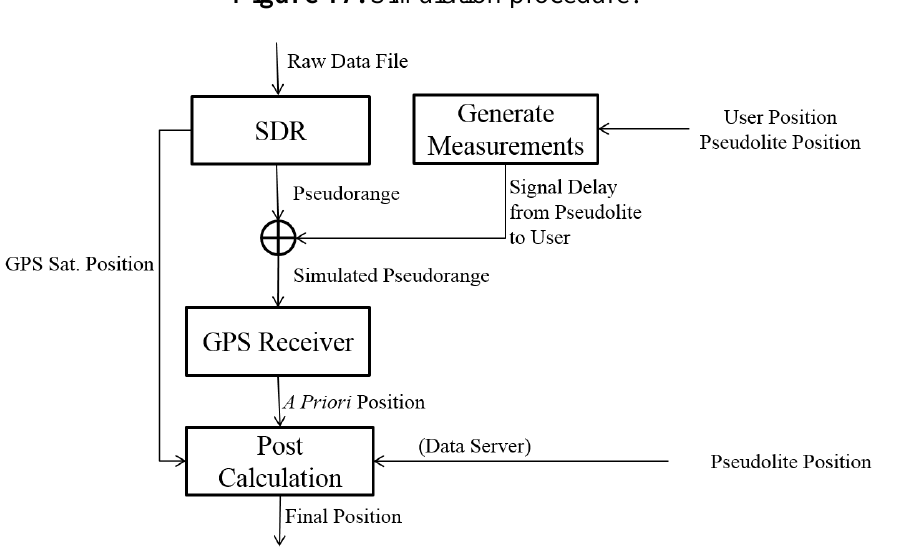
Figure 17. Simulation